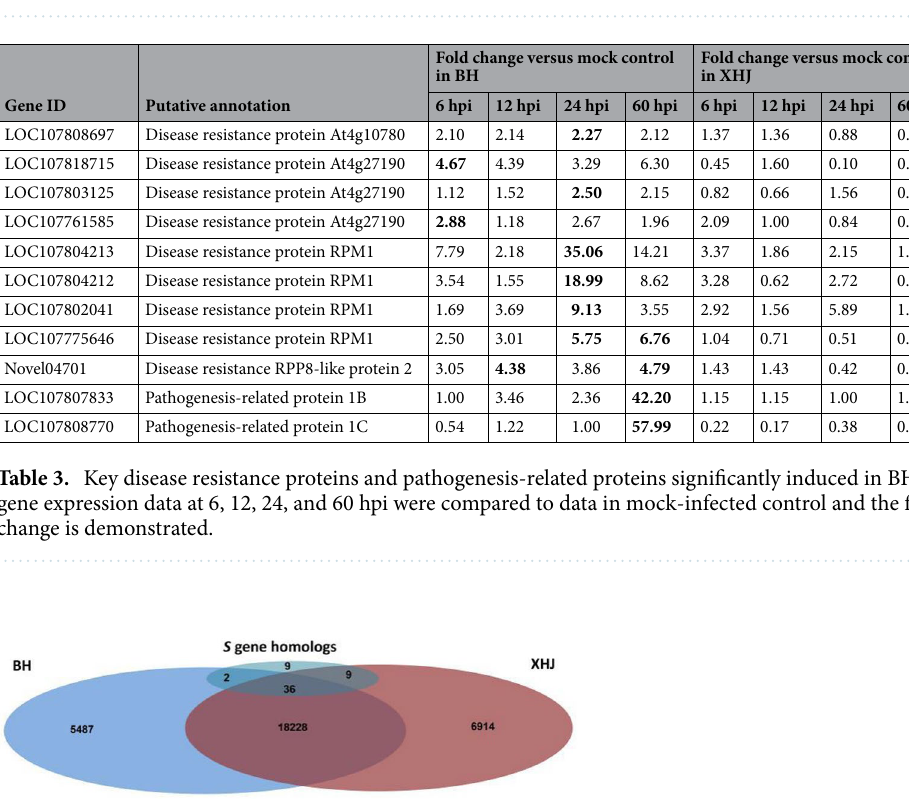
Figure 5. Expression profiles in BH and XHJ of 38 specifically regulated DEGs in BH within the “plant pathogen interaction pathway”. Genes in red are upregulated, whereas those in blue are downregulated. The regulation of genes is based on log2 fold change compared to the mock-infected control samples.